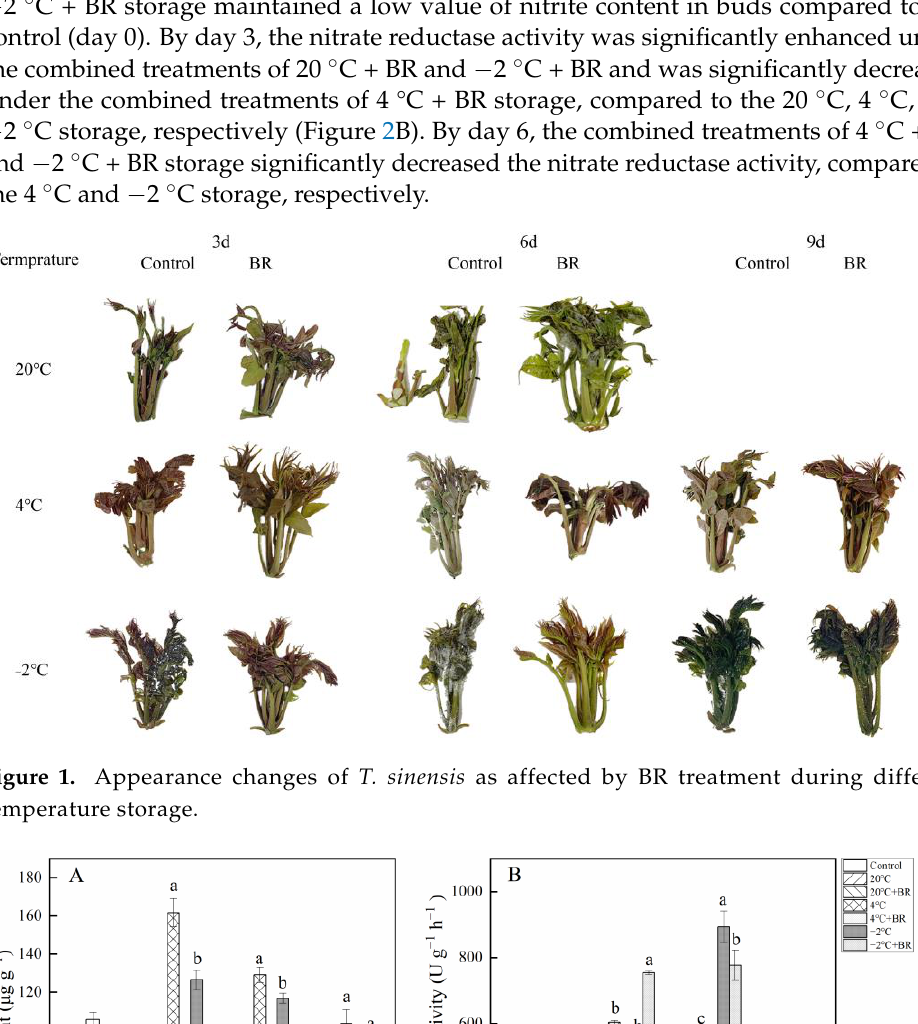
Figure 2. Effects of BR treatment on nitrite content ( A ) and nitrate reductase activity ( B ) of T. sinensis during different temperature storage. Bars with different letters are significantly different at the same storage time under different temperatures and BR treatment ( p < 0.05). Values are the mean of four replicates ± SE.